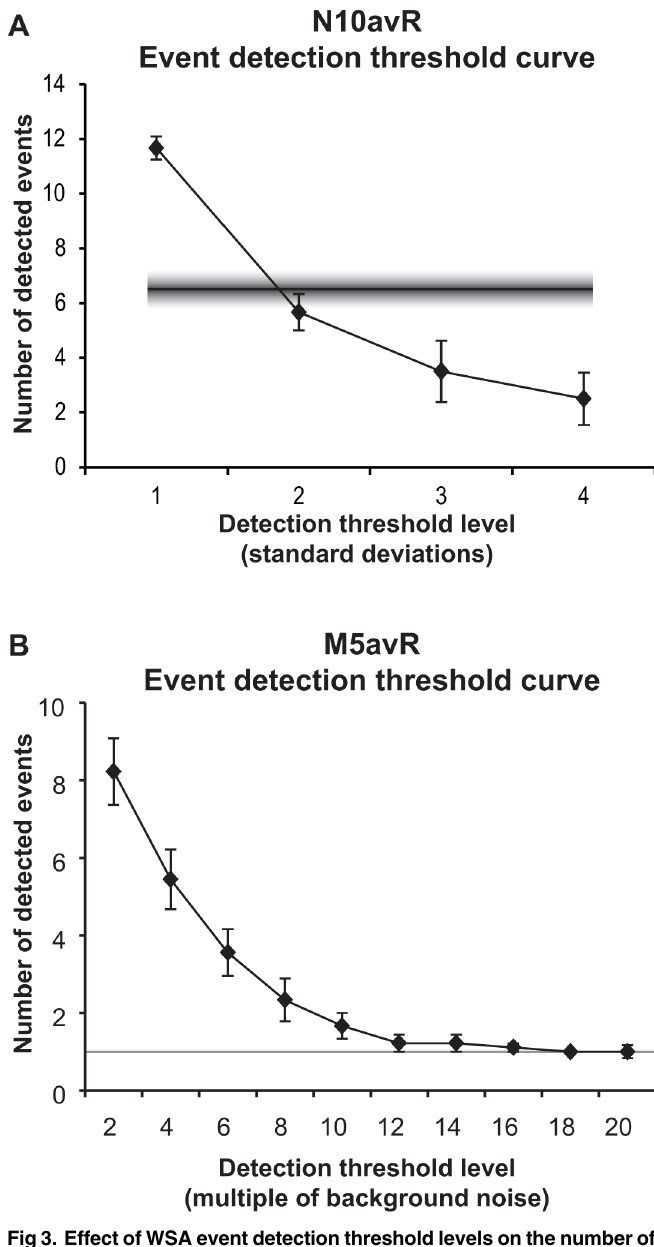
Fig 3. Effect of WSA event detection threshold levels on the number of identified events. Empirically derived functions were used to determine an ideal detection threshold. A demonstrates the mean number of events detected by WSA from N10avRs evoked from injured sciatic nerves by a 0.7 mA stimulus, as a function of the detection threshold level. The detection threshold level indicates the multiple of standard deviations (refer to red line in Fig 2B2 showing one standard deviation) that the mean (black line, Fig 2B2) of 3 repeated N10avRs had to be greater than, in order to detect an event using WSA. The fuzzy line represents the mean and SEM (6.5 ± 0.6) of the number of events detected by TEA for the same responses. Throughout the study, 2.0× was chosen as the standard detection threshold level for N10avRs, as this level detects a number of events not significantly different to that detected by TEA. B demonstrates the mean number of events detected from M5avRs evoked from injured sciatic nerves by a paired stimulus as a function of background noise level. The paired stimulus was 0.7 mA with an inter-pulse interval of 1 ms. Background noise was calculated from the mean absolute amplitude of the last 17 ms of the sweep, a region where no signal was present. The detection threshold level indicates the threshold based on a multiple of background noise. The grey line indicates the ideal level of event detection, i.e. where the number of events = 1. For in vivo experiments, 12× the background noise level was chosen as the standard detection threshold level for